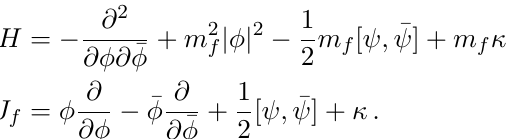
= m f < 0 for a single chiral f g (cid:0)